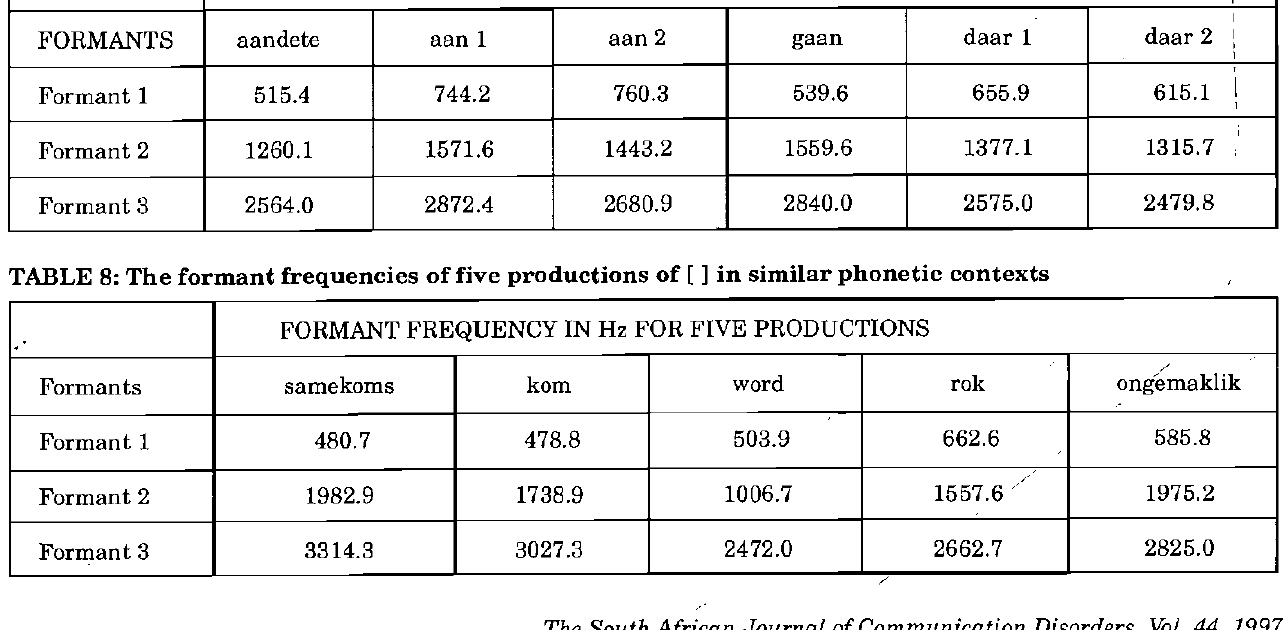
TABLE 7: The formant frequencies of six productions of [a] in similar phonetic contexts FORMANT FREQUENCY IN Hz FOR SIX PRODUCTIONS